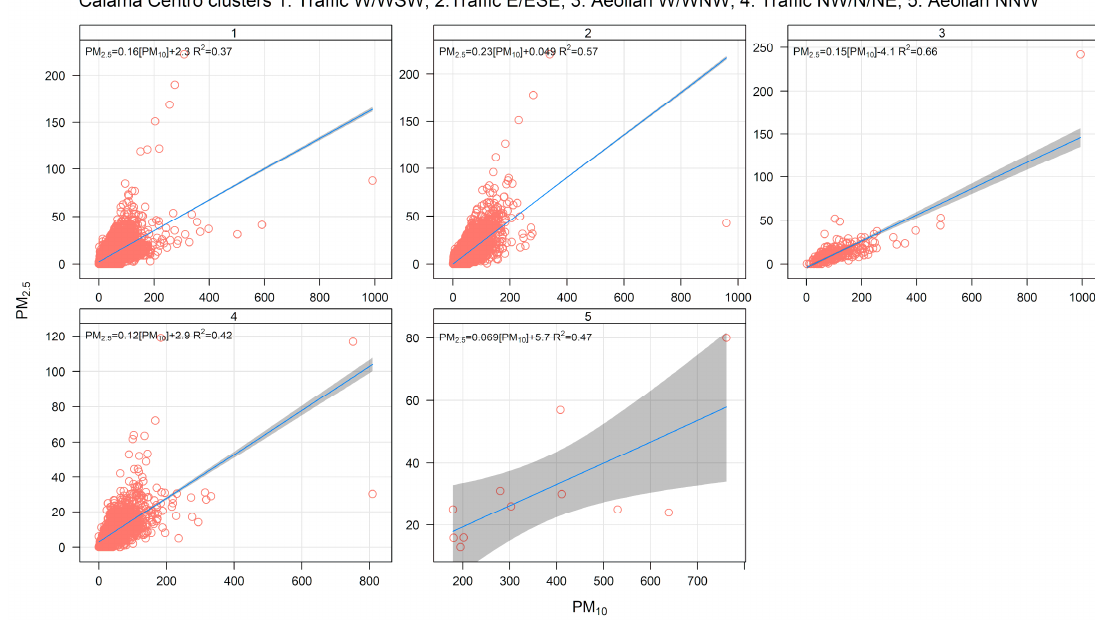
Figure 5. Time variation plot for cluster analysis source apportionment results for ambient NOx at Calama, 2012/10–2020/08, for a five-cluster solution. Only clusters 1, 2, and 4 are plotted for clarity’s sake.